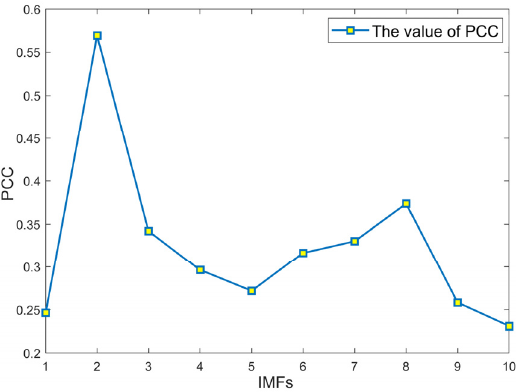
Figure 10. PCC value between BLIMFs and the noisy radiation signal.